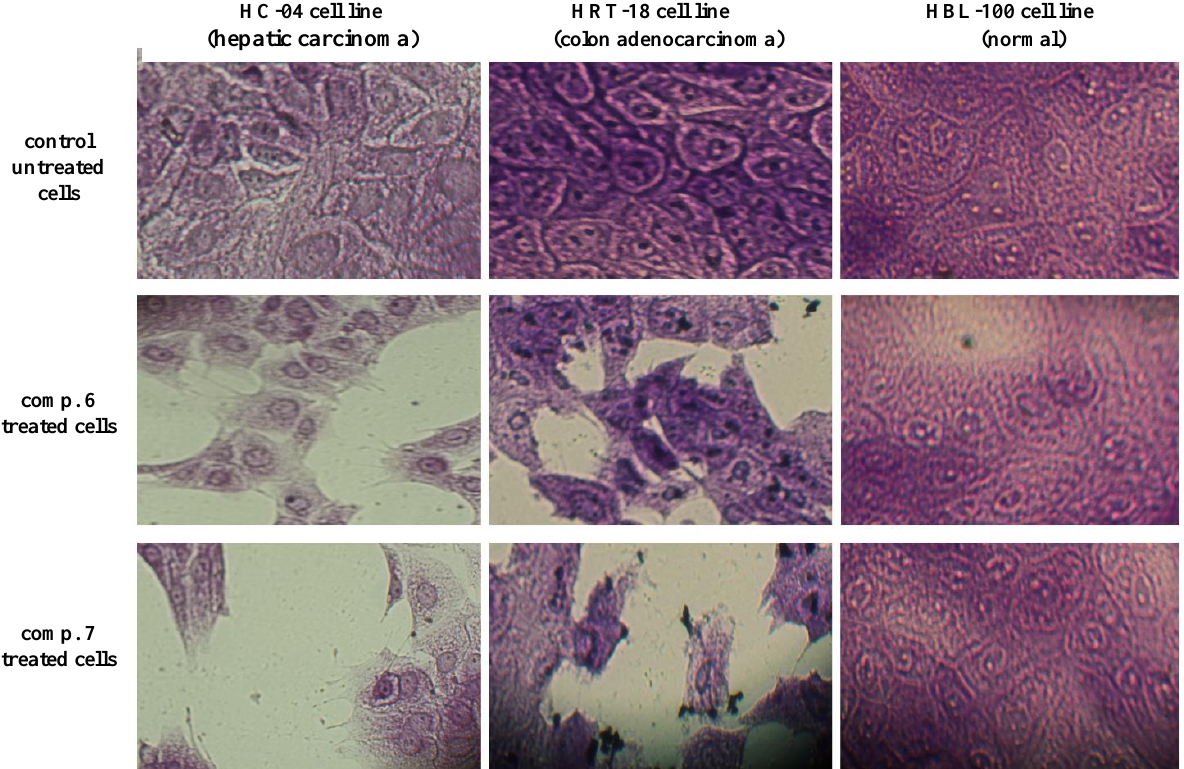
Figure 6. Morphology of the cell lines after treatment with compounds 6 and 7 at the IC 50 (40x magnified)